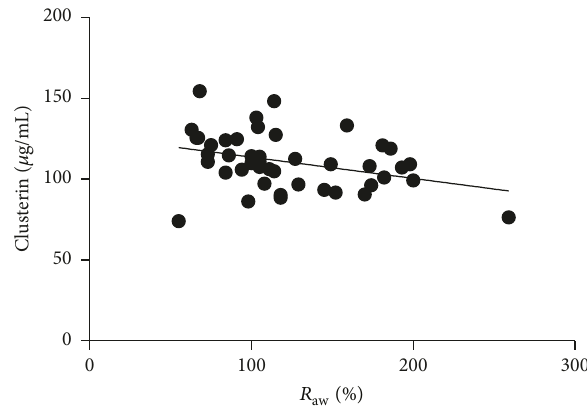
Figure 6: Negative correlation of 𝑅 aw and circulating clusterin levels in asthmatic patients (pregnant and nonpregnant). 𝑝 = 0.0128 ; 𝑟 = −0.3723